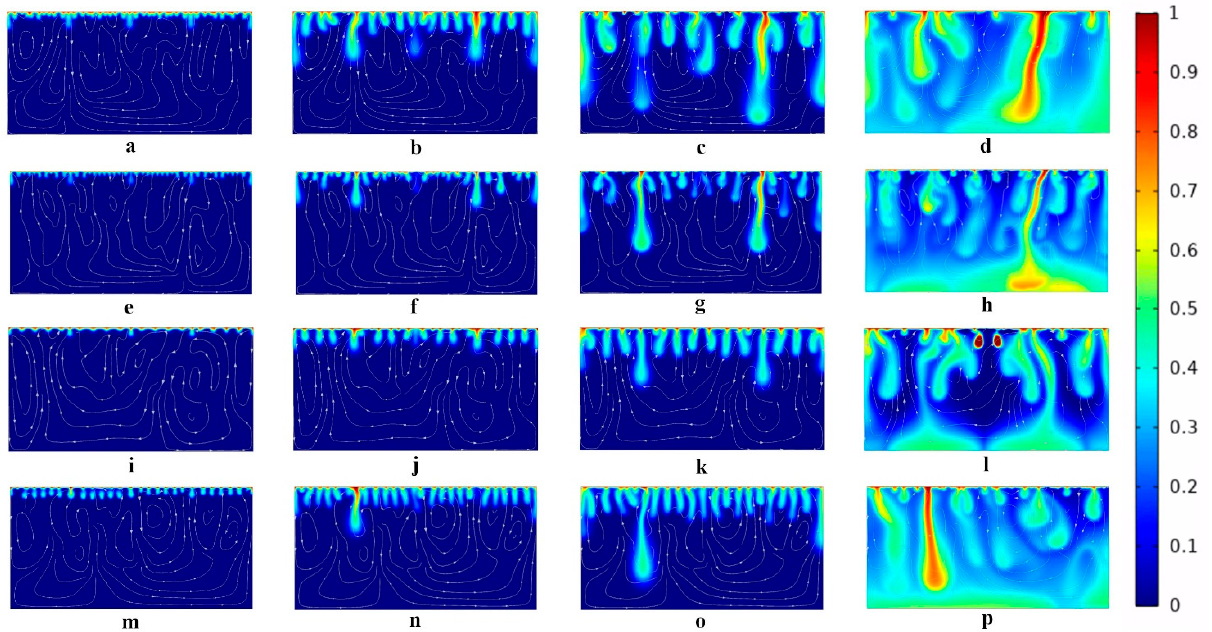
Figure 5. Dissolved CO 2 patterns for cases 7-p (first row), 13-i (second row), 9-p (third row), and 18-i